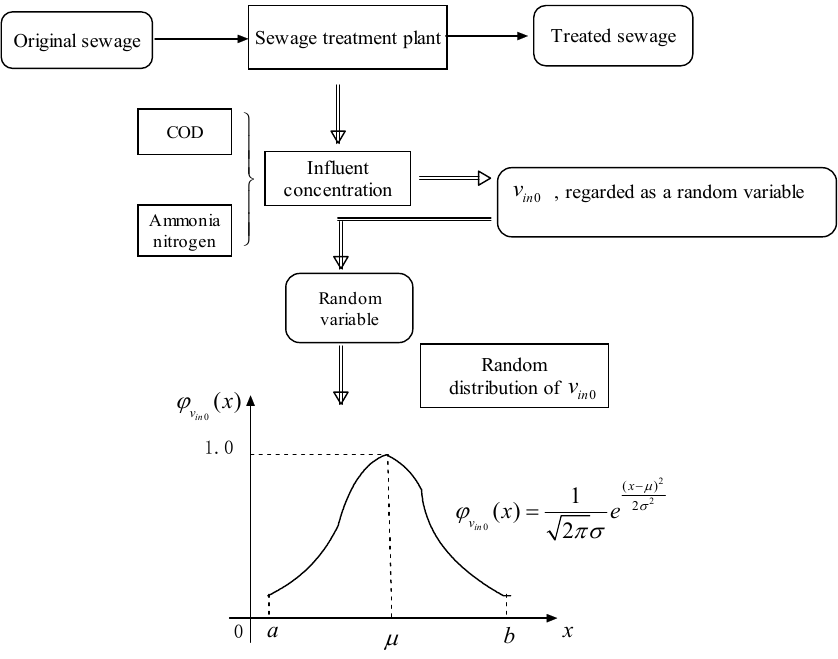
Figure 1. Uncertainty of urban sewage treatment problem.